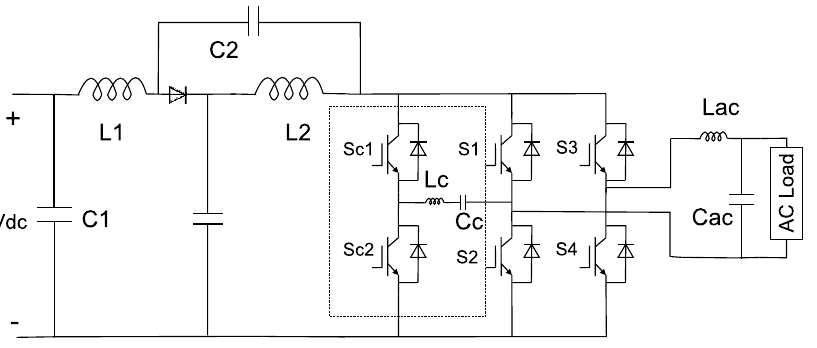
Figure 6. Active filter for